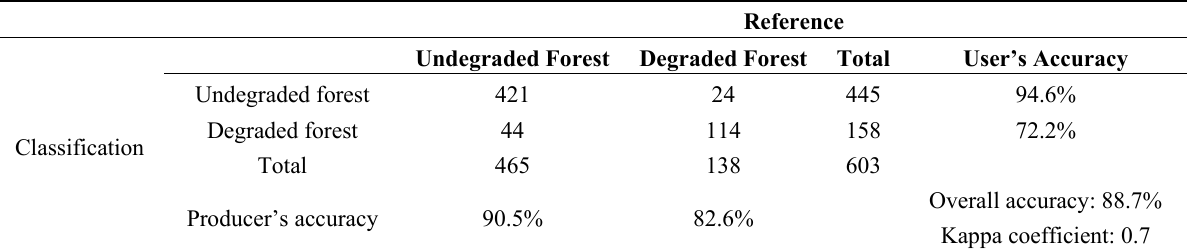
Table 4. Confusion matrix for CAR degradation map, 603 label points